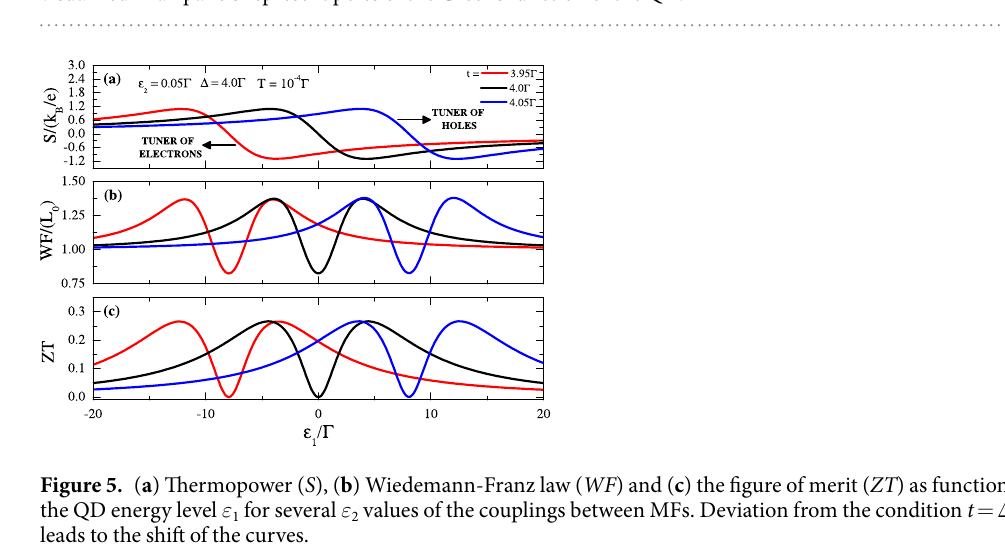
downwards by ε 1 scale for t < Δ (panel (d), redshift of the resonant curves in the Fig. 3). It should be noted that similar results to the transmittance were reported both theoretically (ref. 30 ) and experimentally (ref. 31 ) for the geometry of a linear Kitaev wire with a QD attached to one of its ends placed between source and drain metallic leads. Differently from the case considered in our work, the authors account for the spin degree of freedom and particularly for ref. 31 , they evaluate the dependence of the conductance on the energy level of the QD and mag- netic field, while we further analyze ε and asymmetry of couplings dependencies relevant for the understanding